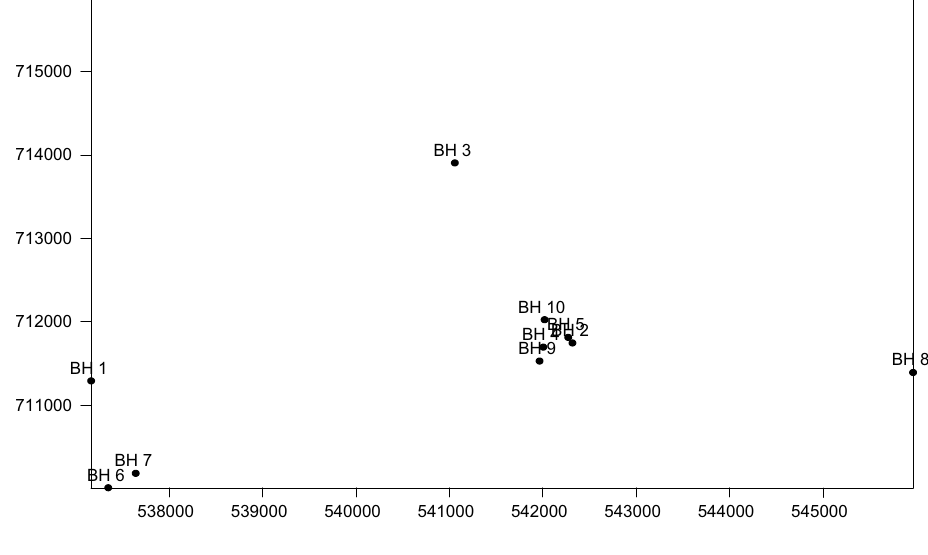
Fig. 2 Location map of the study area showing the posi- tions of the boreholes